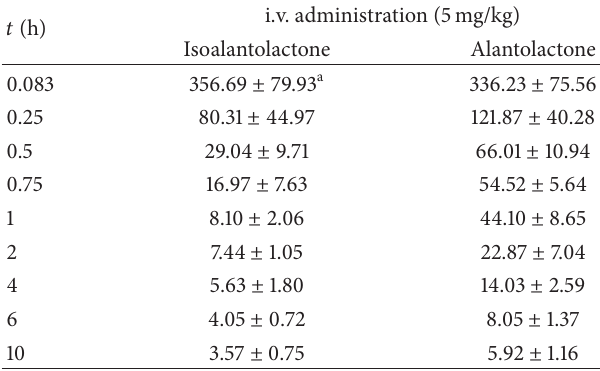
Table 4: Mean plasma concentrations of the lactones ( 𝐶 , ng/mL) over time.